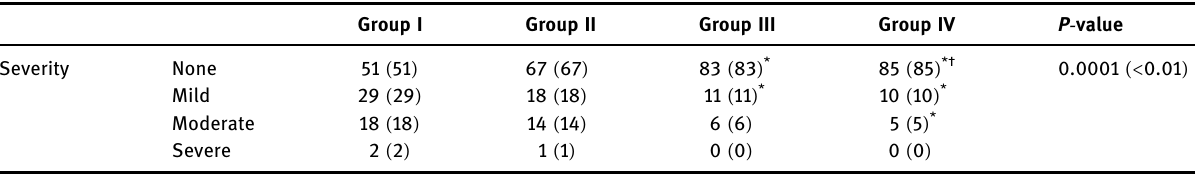
Table 3: The severity of dexamethasone - induced perineal irritation